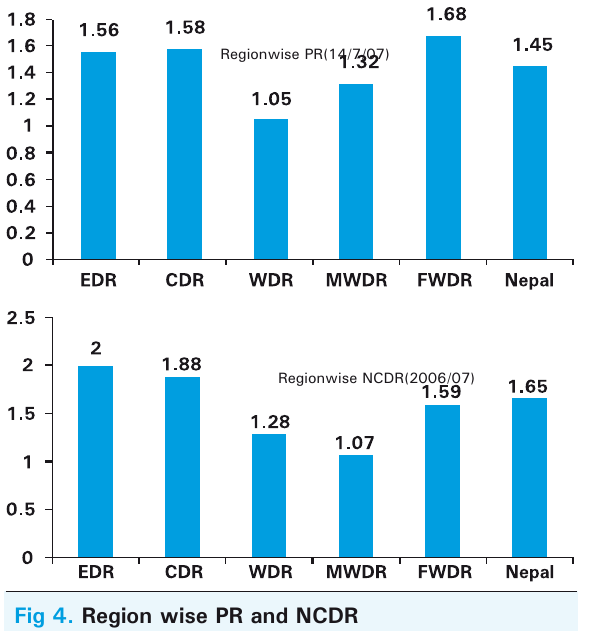
Fig 4. Region wise PR and NCDR